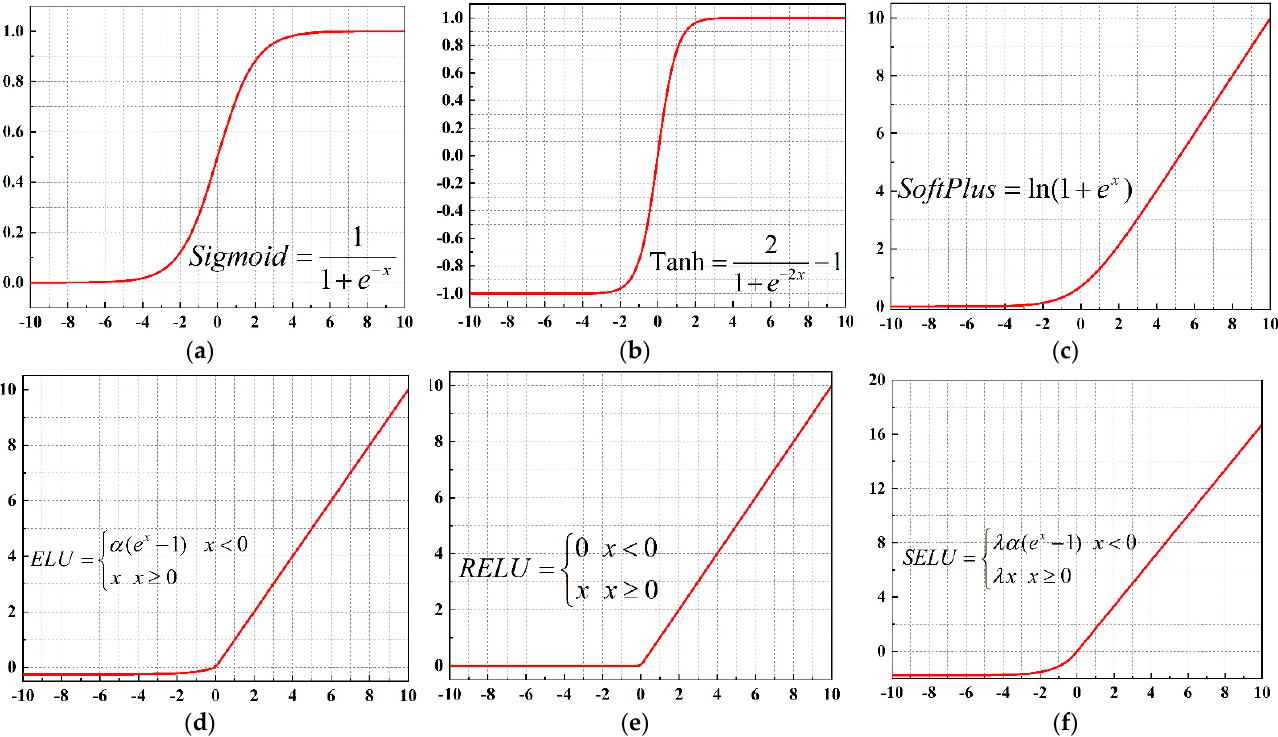
Figure 2. The waveforms of different activation functions. ( a ) Sigmoid; ( b ) Tanh; ( c ) SoftPlus; ( d ) ELU; ( e ) RELU; ( f ) SELU.